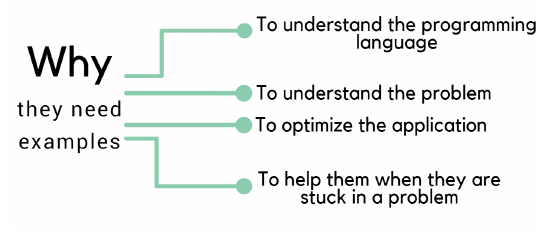
Fig. 3. Why novice programmers need